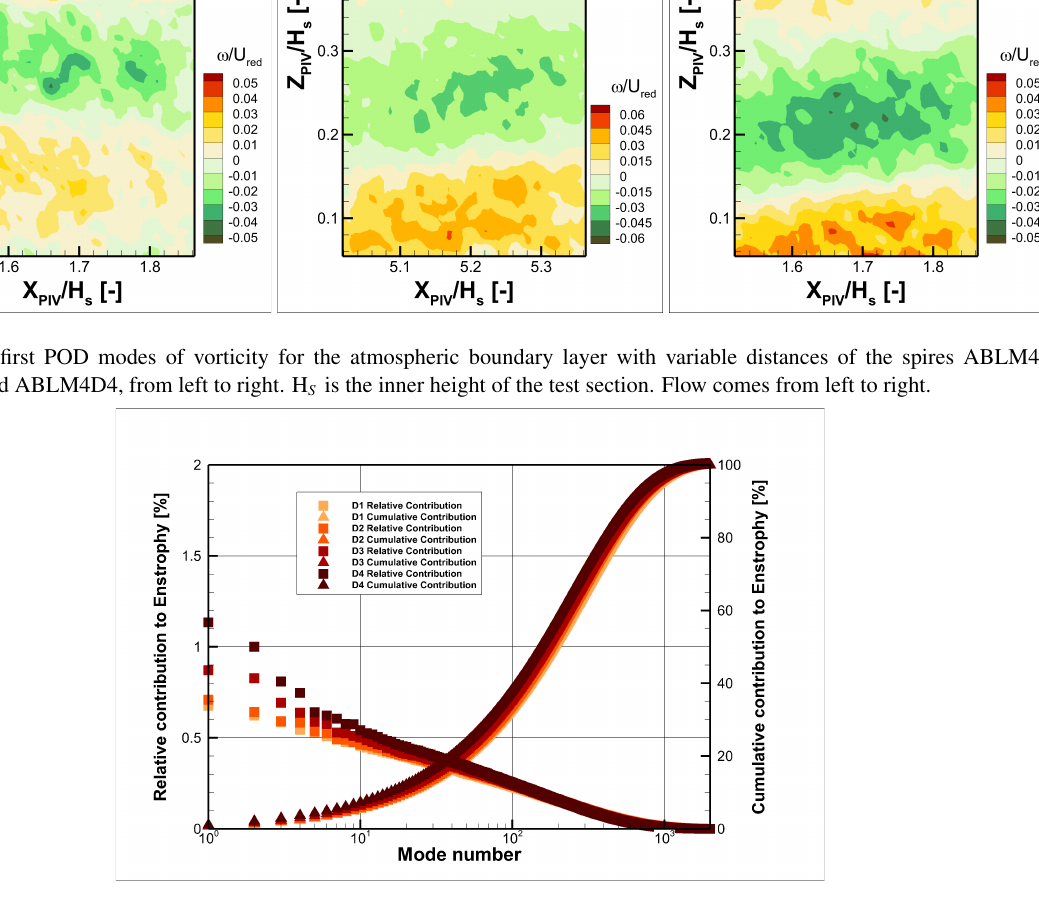
Fig. 8. The relative contribution of the POD modes to the total vorticity for the ABLM4D1-ABLM4D4 cases. The abscissa represents the mode number. Left coordinate represents the relative contribution, right coordinate represents the cumulative contribution.